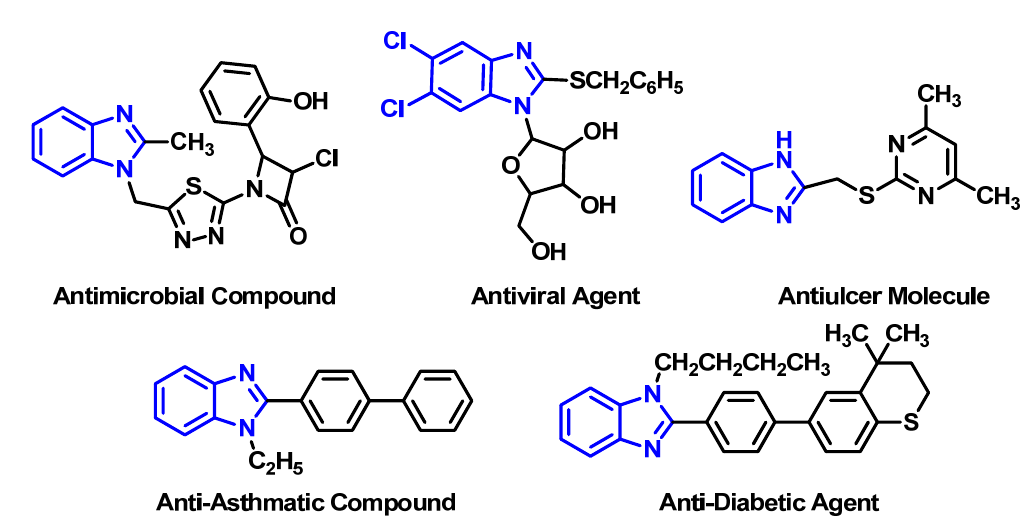
Figure 1. Examples of some biologically active benzimidazoles.